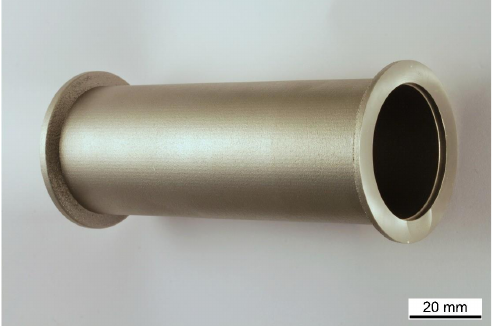
Figure 3. KF 40 pipe printed from stainless